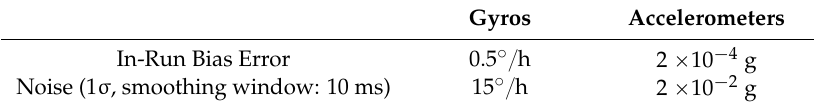
Figure 10. The (strapdown) INS used in the missile test. Table 4. Gyro and accelerometer specifications.